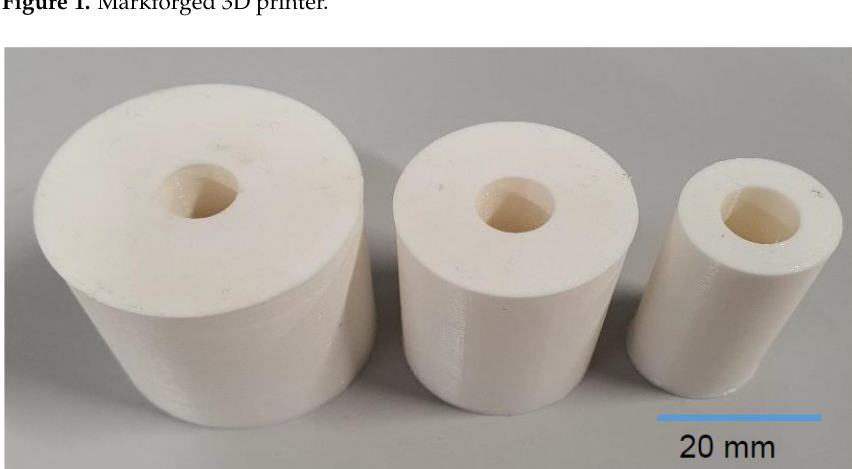
Figure 1. Markforged 3D printer.